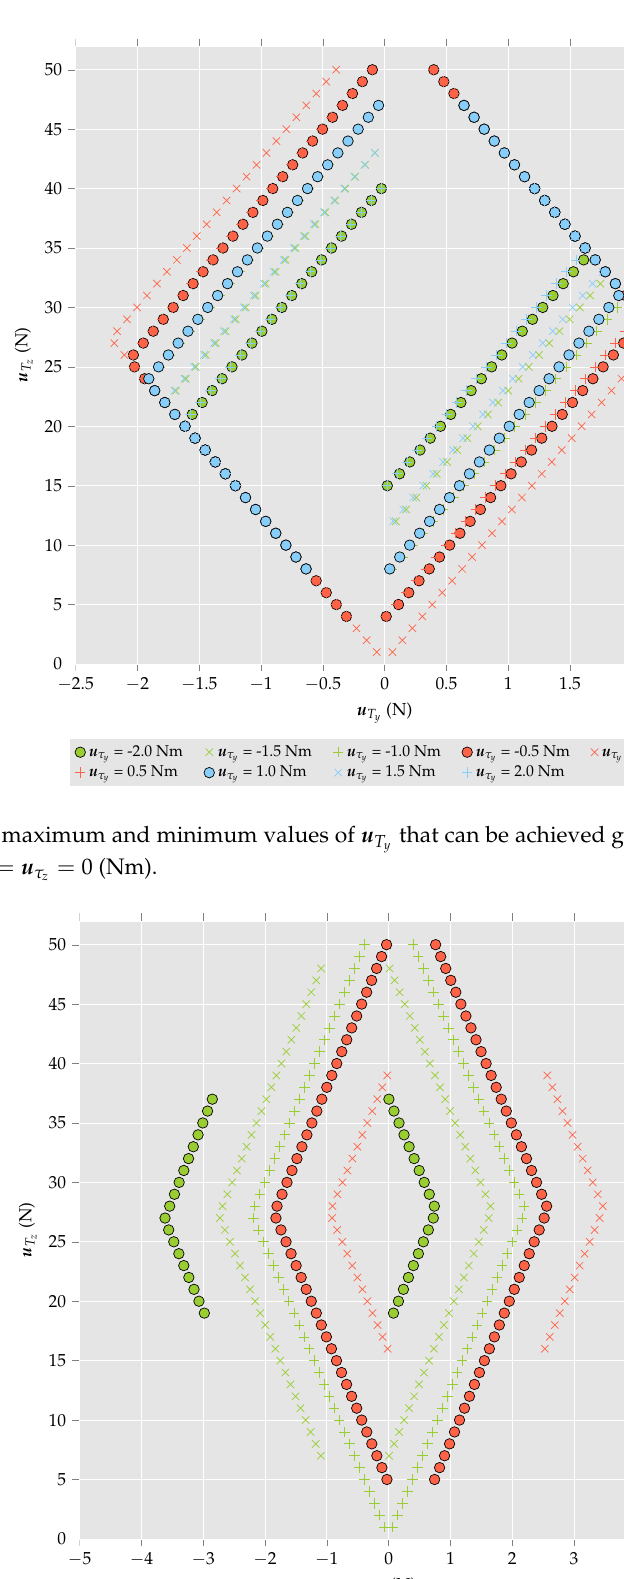
Figure 4. The maximum and minimum values of u T y that can be achieved given a set of u T z and u τ . Note that u τ x = u τ y = 0 (Nm).